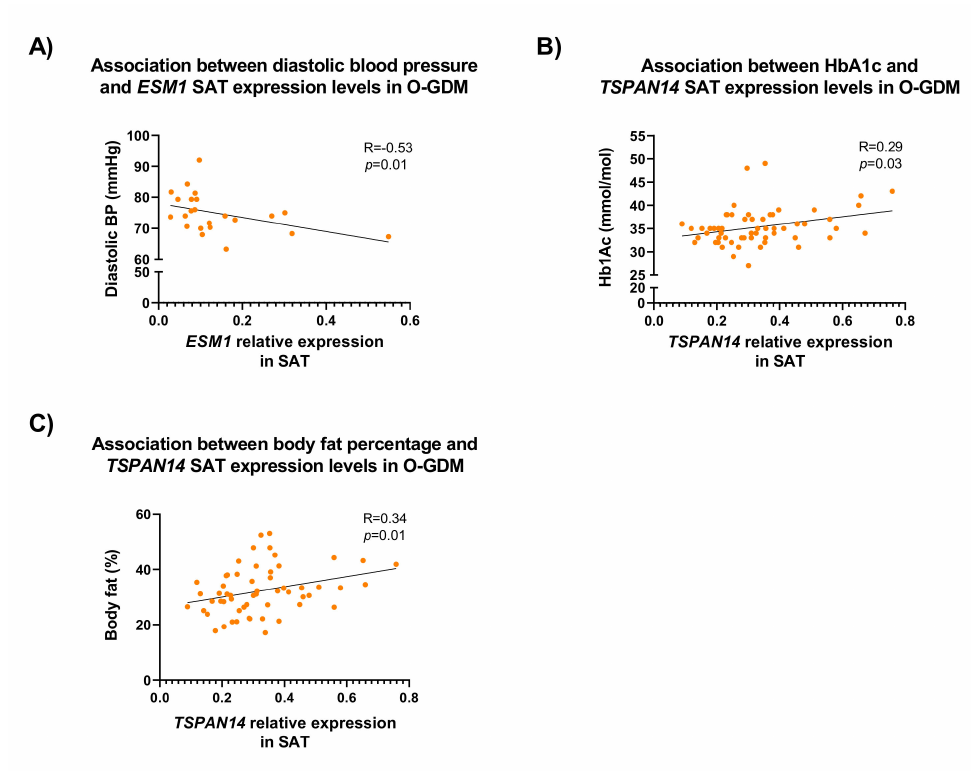
Figure 6. Association between subcutaneous adipose tissue (SAT) ESM1 and offspring diastolic blood pressure ( A ), and SAT TSPAN14 expression and offspring HbA1c levels ( B ) and fat percentage ( C ). R-values and p -values were calculated using a Spearman rank test. O-GDM: offspring of women with